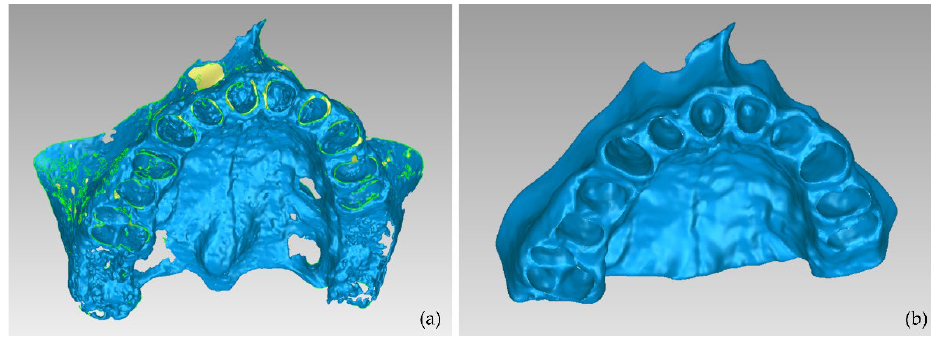
Figure 11. Views of the 3D model of the alveolar bone during its processing phase (Experiment 3).